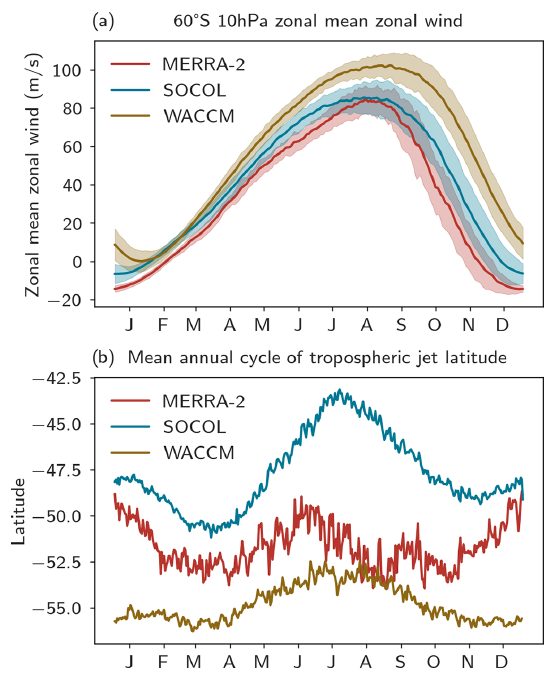
Figure 7. Mean annual cycle of the 10hPa zonal mean zonal wind at 60 ◦ S with the standard deviation (shading) (a) , and the mean annual cycle of the daily jet latitude index, defined as the location of the maximum 850hPa zonal mean zonal wind between 35 and 70 ◦ S for MERRA-2 and the CCMs WACCM and SOCOL (b)